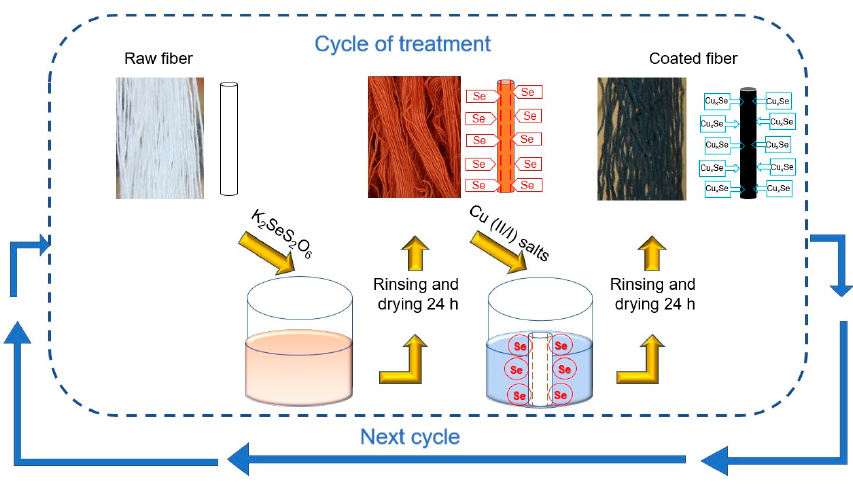
Figure 1. Procedure scheme for the fiber treatment process with Cu x Se.